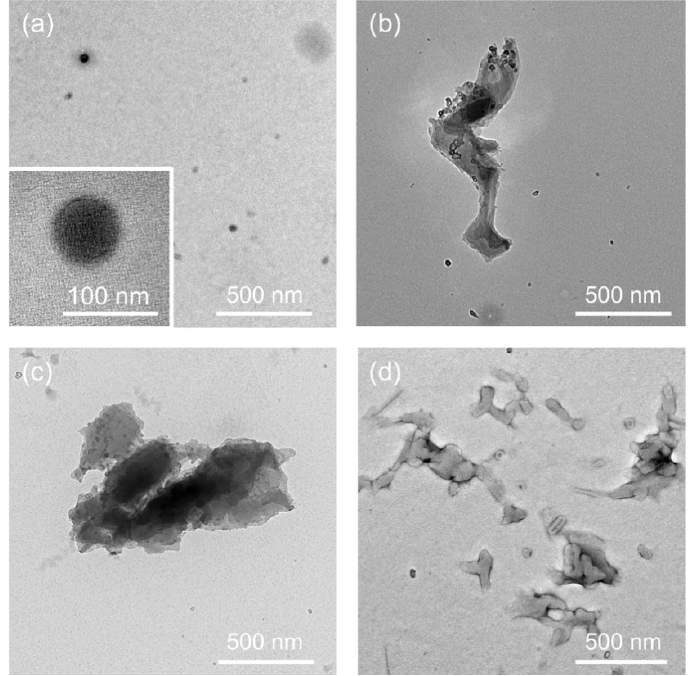
Figure 2. Transmission electron microscopy (TEM) images of the objects in the supernatants after sonication and subsequent centrifugation. ( a ) Biocomposite PPO nanoparticles prepared in the presence of PPO-binding peptide. ( b ) PPO aggregates prepared in the absence of peptides. ( c ) PPO aggregates prepared in the presence of the naphthalene-binding peptide. ( d ) Aggregates of the PPO- binding peptide.